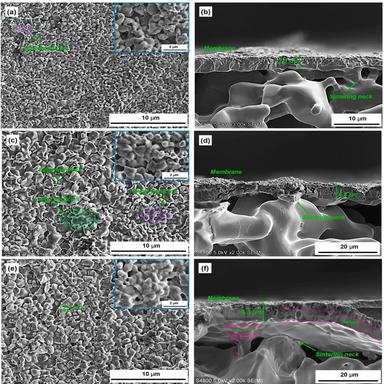
SEM micrographs of the membrane and cross section of samples prepared by different powders with sintered pressure of 30 kPa at 1000 ℃, (a) and (b): coarse powder; (c) and (d): middle powder; (e) and (f): fine powder.